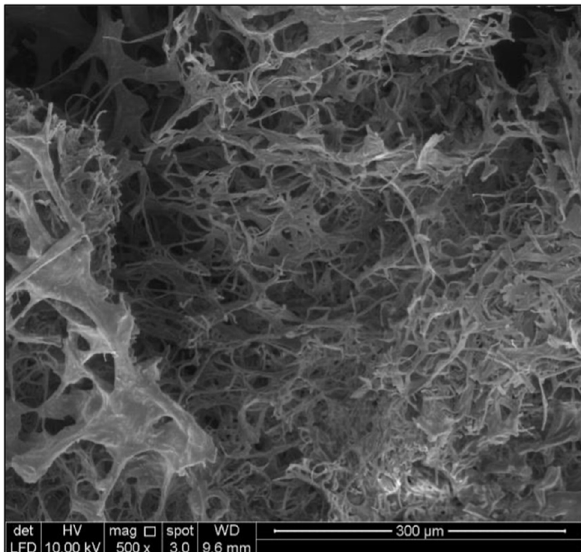
Figure 8: SEM image of membranous pellicle produced by USM - YBP2 showing an interwoven network of fi bers under 500 × magni fi cation.